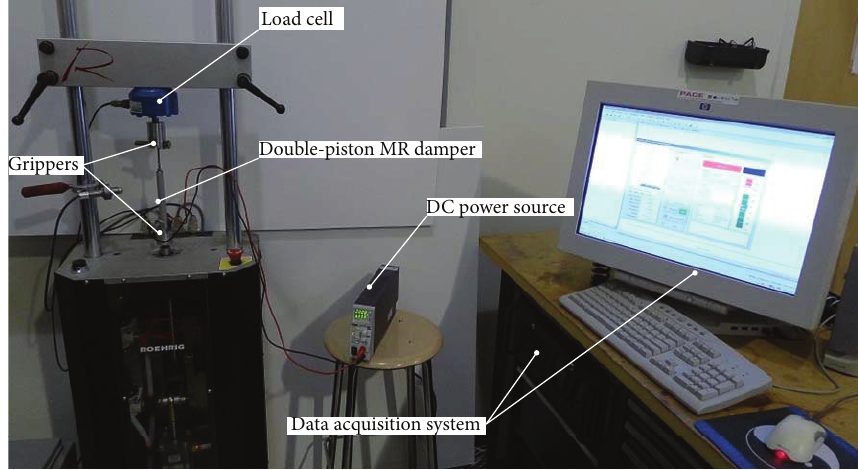
Figure 10: Experimental setup for the prototype damper.